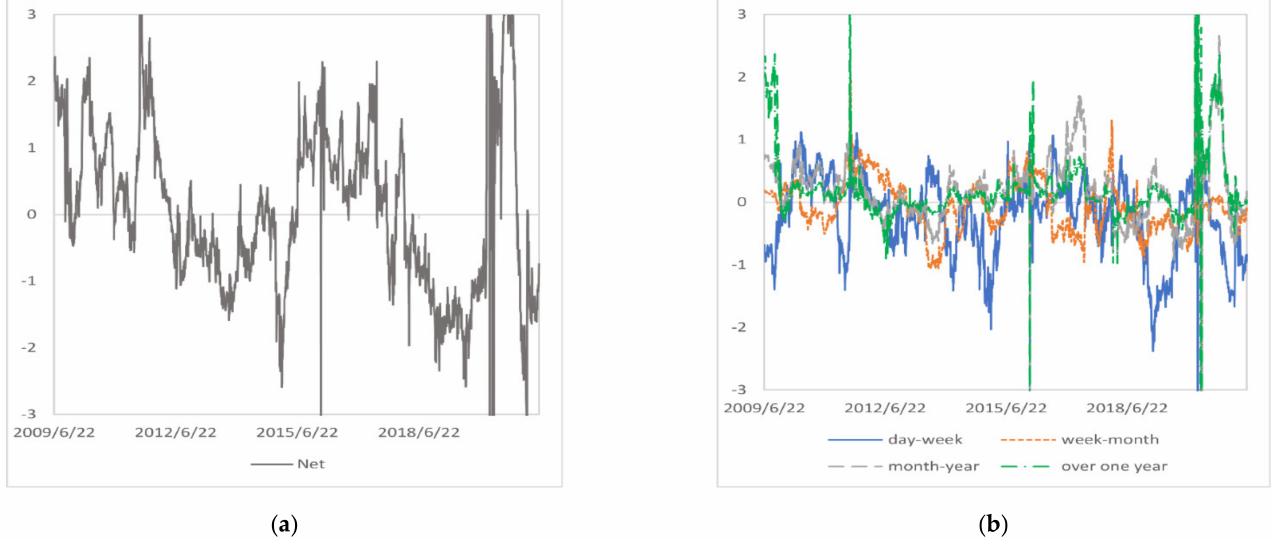
Figure 11. Net directional connectedness of NEX in the price volatility system. ( a ) net directional connectedness. ( b ) frequency decomposition of net